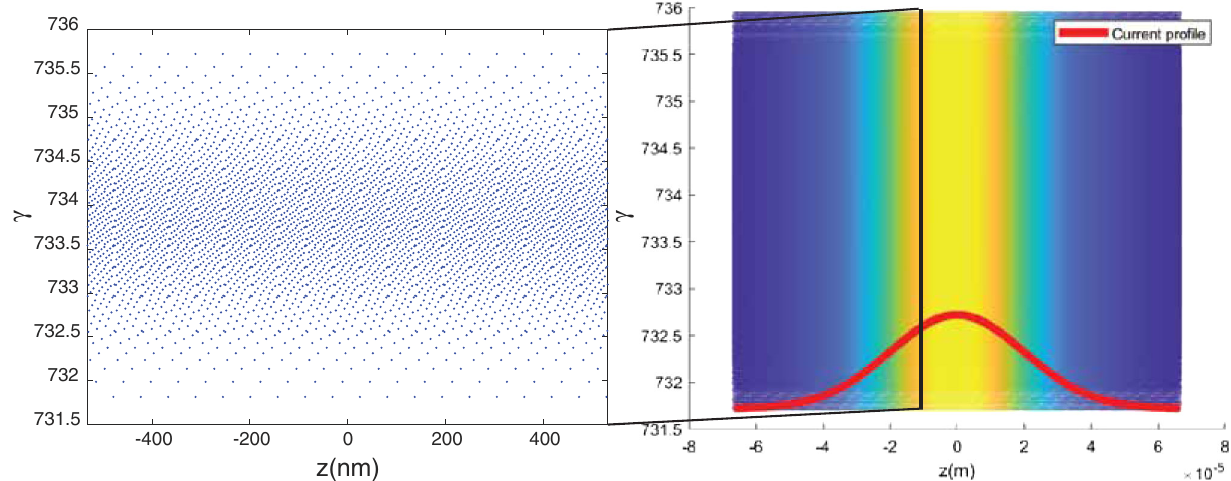
FIG. 2. Left: longitudinal phase space distribution with quiet loading for time-independent (i.e., single frequency) simulation. Right: longitudinal phase space distribution for multifrequency simulation. Particles are color coded by their charge weight. The projection onto the z-axis shows the Gaussian current profile.